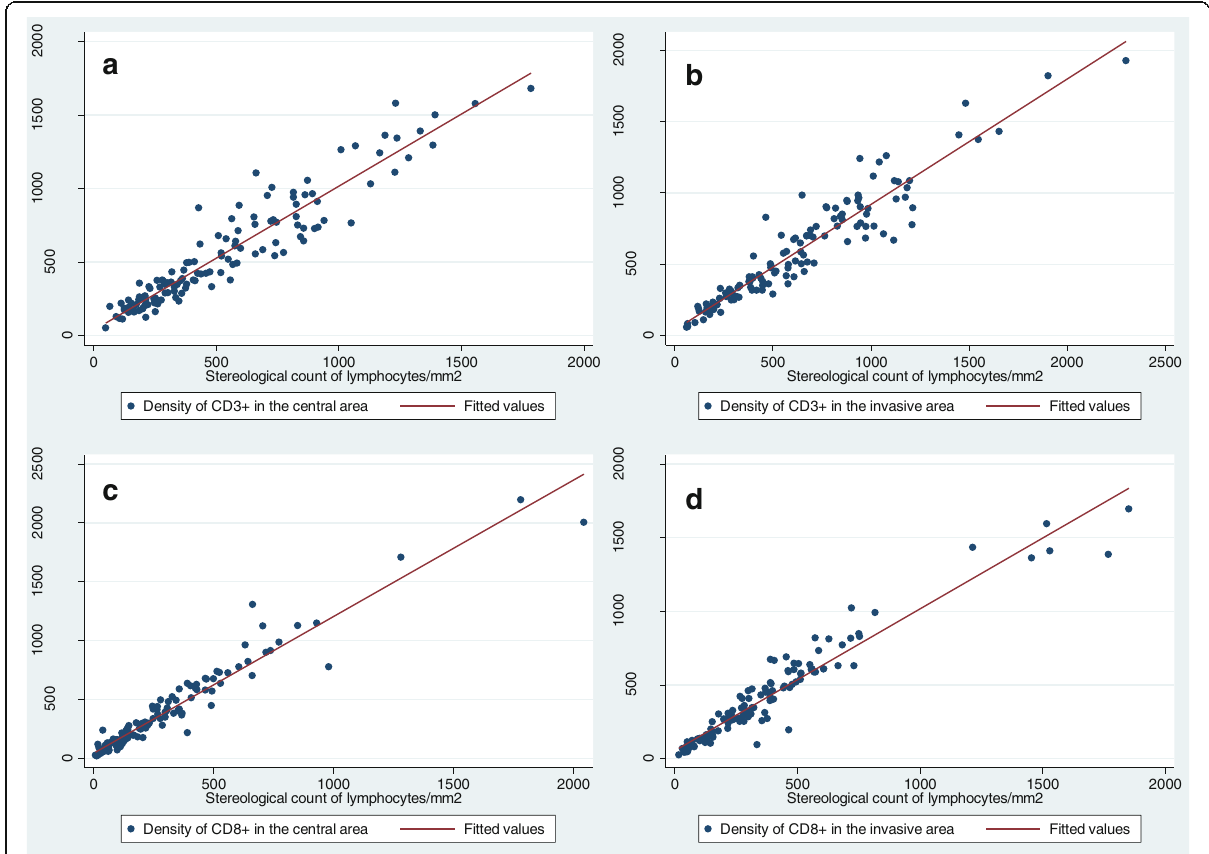
Fig. 6 Correlation between cell counts as obtained by stereology and image analysis. a ) Correlation for CD3+ tumor infiltrating lymphocytes (TILs) numerical density in the central area of the tumor. b ) Correlation for CD3+ TILs numerical density in the invasive tumor front. c ) Correlation for CD8+ TILs numerical density in the central area of the tumor. d ) Correlation for CD8+ TILs numerical density in the invasive tumor front